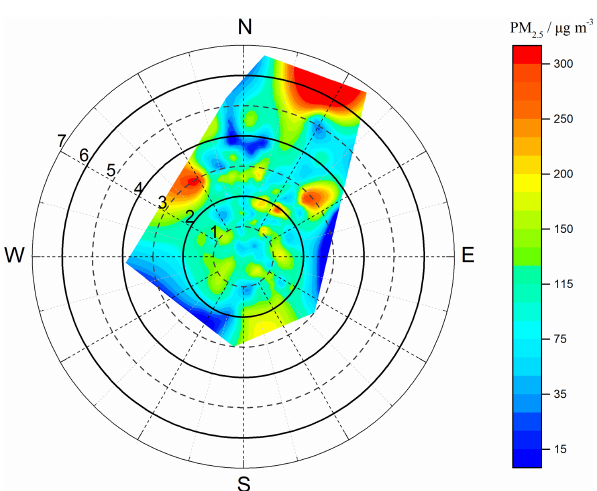
Figure 5. A polar plot of the hourly variations in wind speed (round radius, in units of ms − 1 ) and direction (angles) to surface PM 2 . 5 concentrations (color contours, in units of µgm − 3 ) in Wuhan in January